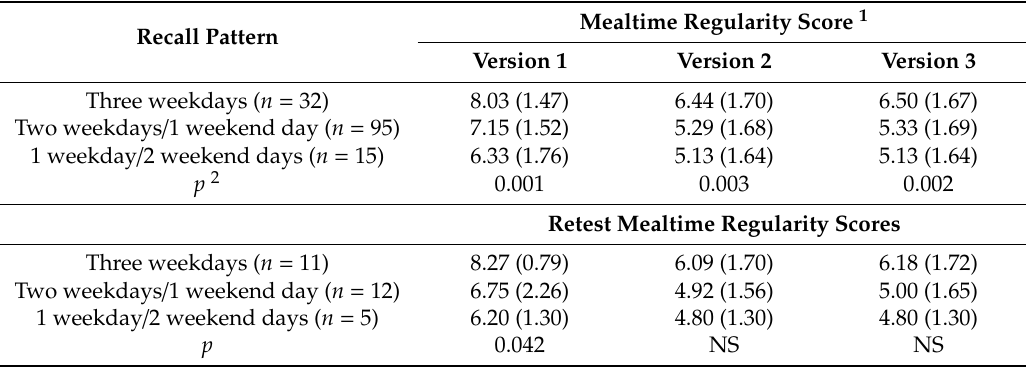
Table 3. Mealtime regularity score compared among day of week recall